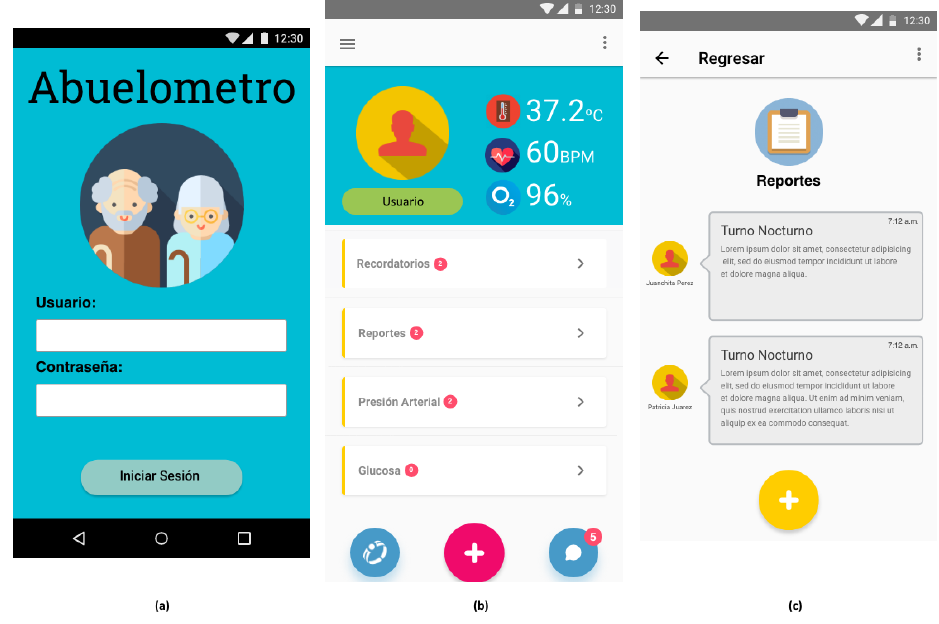
Figure 2. ( a ) Screen for login; ( b ) main screen with monitoring data and notifications; and ( c ) communication screen.